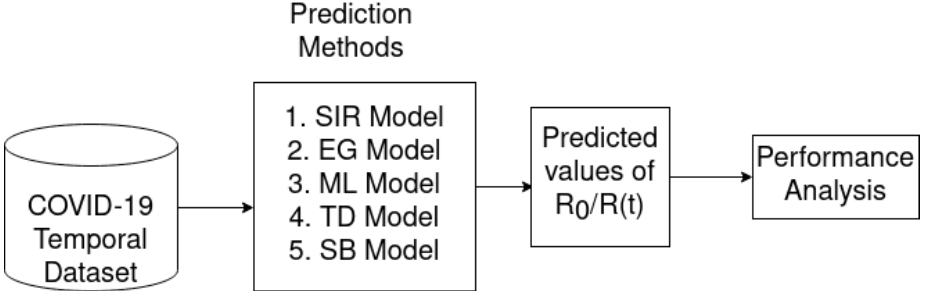
Figure 1. Overall architecture to estimate reproduction number ( R 0 / R ( t ) ) of COVID-19